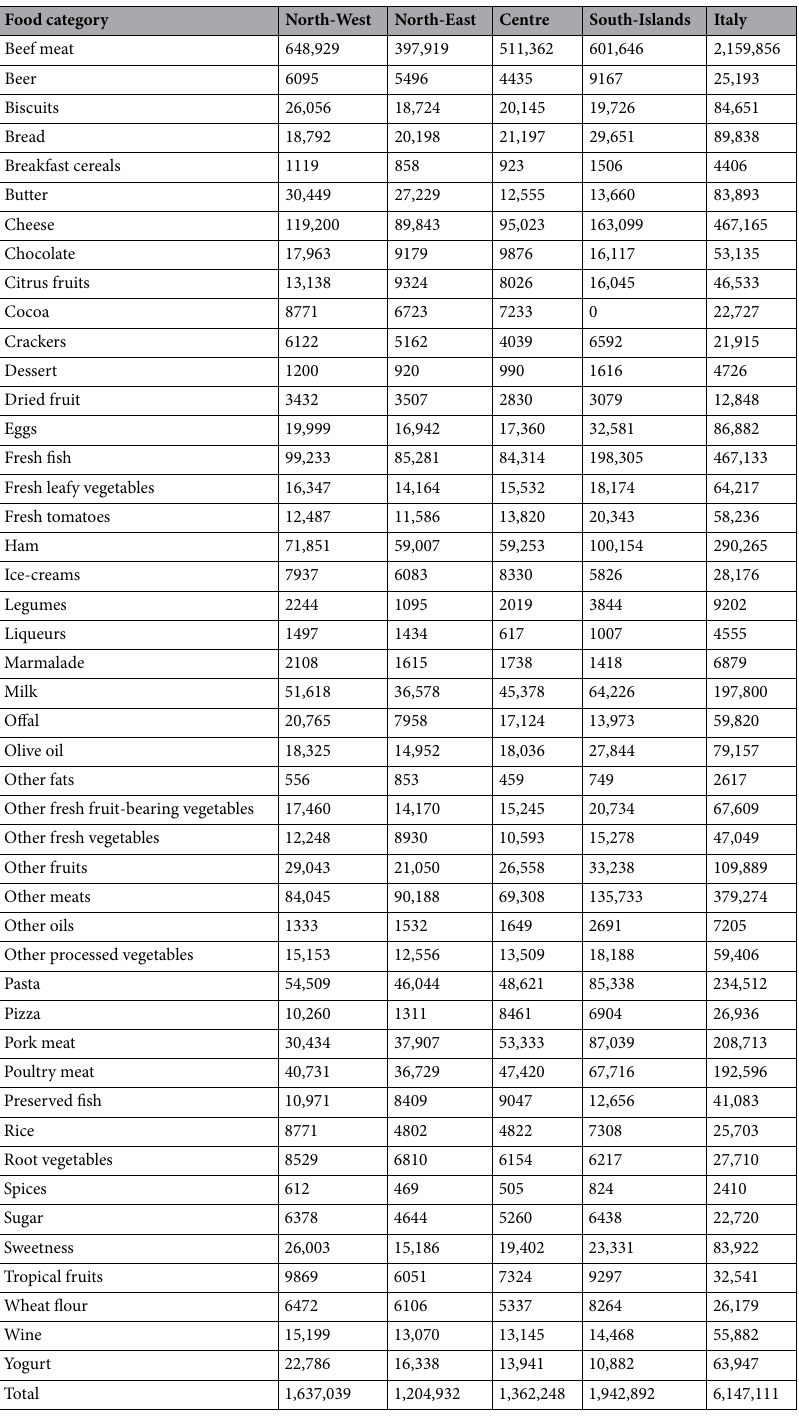
Table 2. Total GHG emissions of overnutrition in Italy, broken down by food categories, and calculated for each macro-region and for Italy as a whole. All data is expressed in t CO 2 -eq per